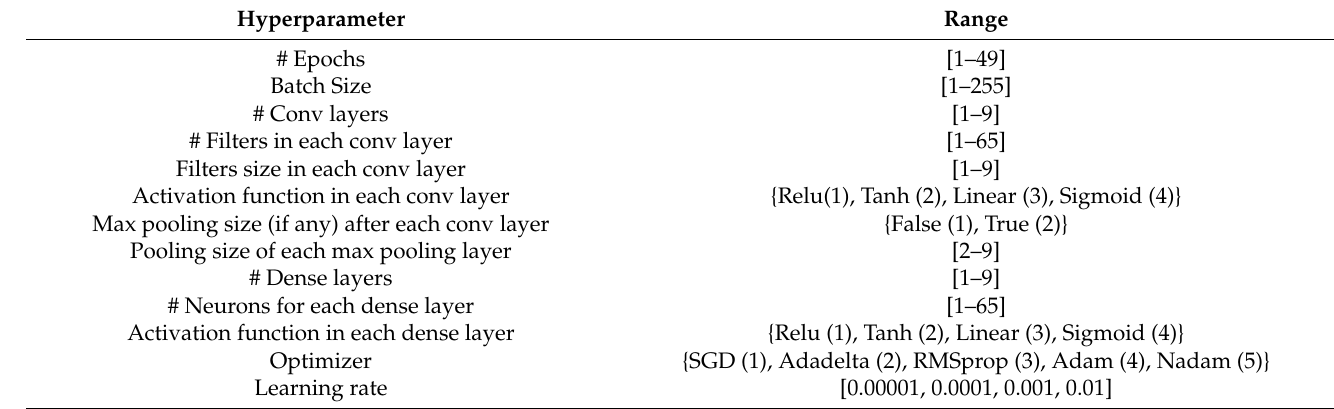
Table 1. CNN architecture hyperparameters and